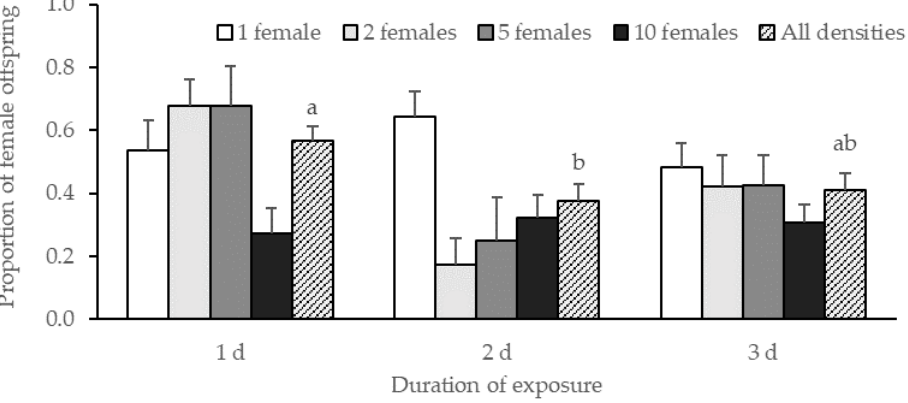
Figure 1. Proportion of G. aetherium female offspring ± SE produced at different female densities after 1, 2, or 3 d of exposure to B. hilaris eggs. Bars with different letters are significantly different (Tukey’s HSD, p < 0.05).